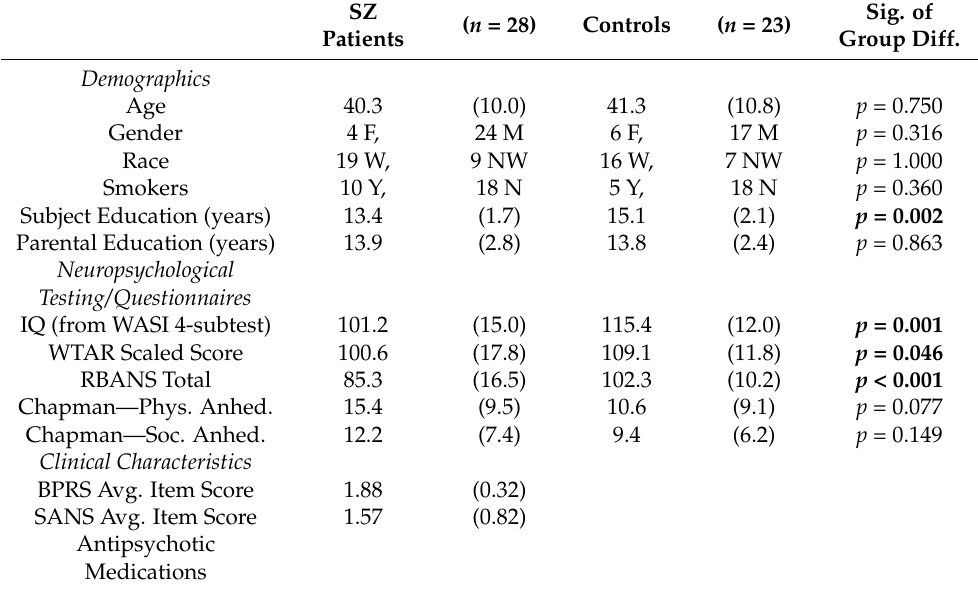
Table 1. Subject characterizing